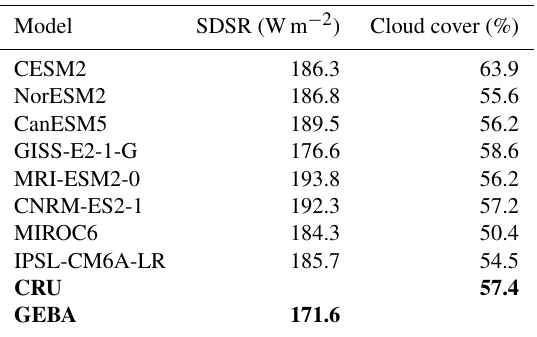
Table A1. Global all-sky SDSR and cloud cover averaged over the years 1961–1966 (baseline values) as observed (GEBA for radiation, CRU for cloud cover) and as simulated in the ensemble mean of three ensemble members in the historical experiment by each of the models of this study. Data from both CRU and models are retrieved after co-location to all GEBA